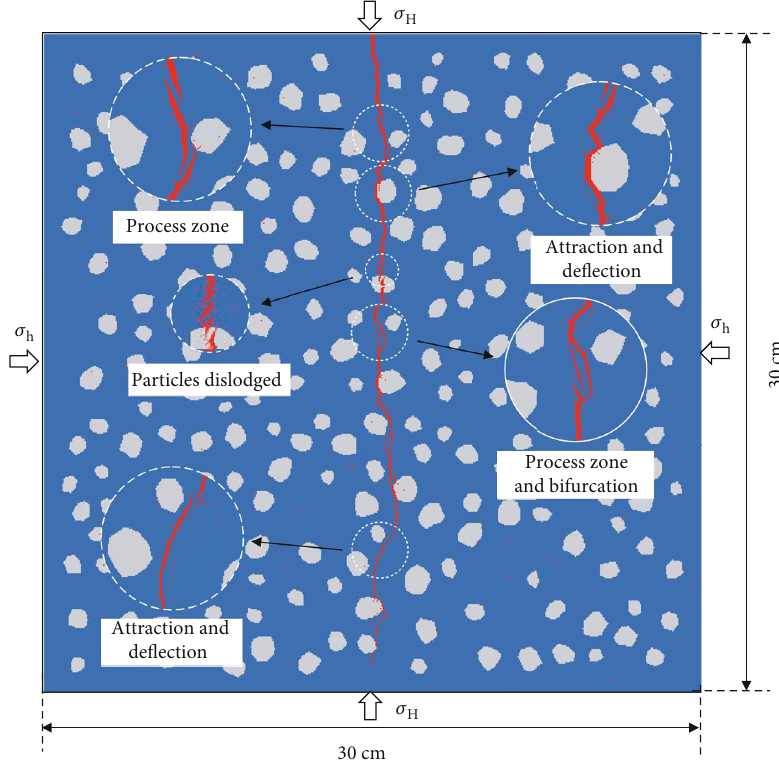
Figure 4: Propagation morphology of HF in the